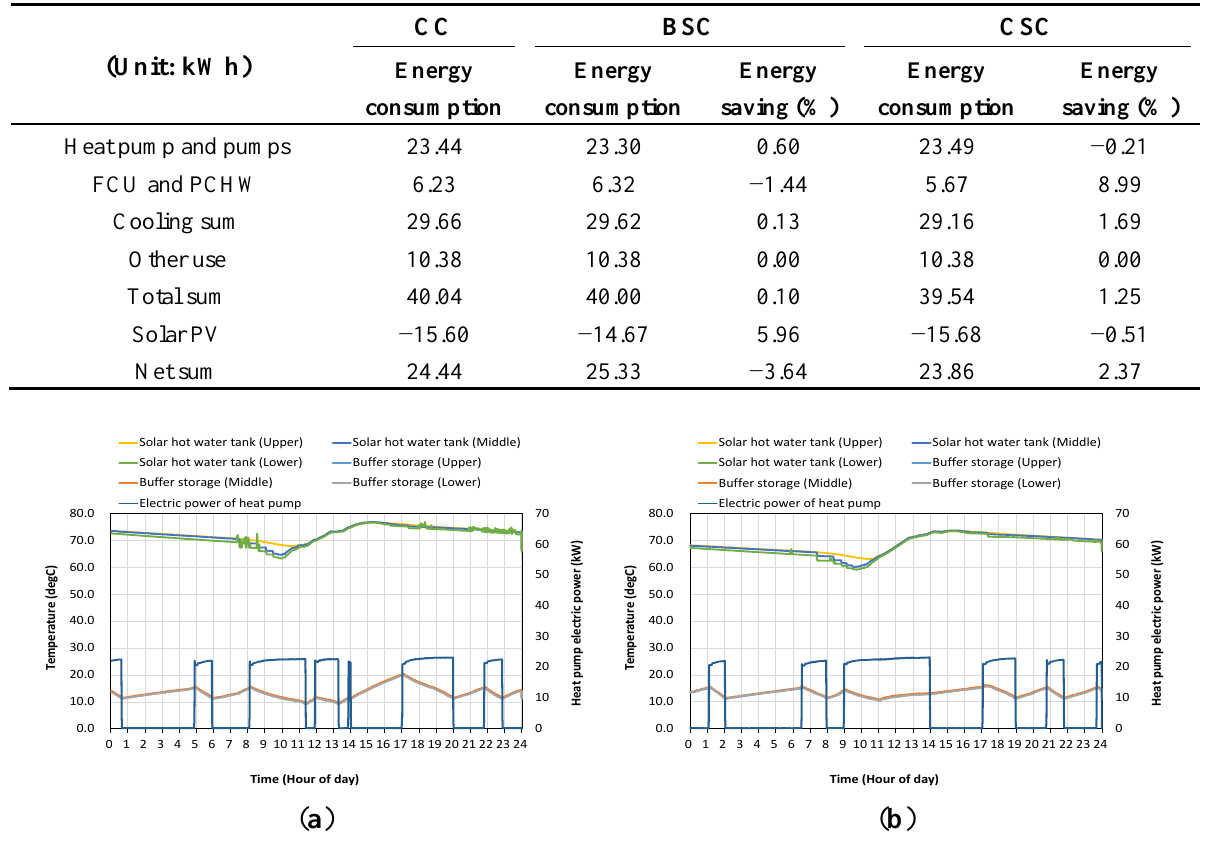
Figure 10. Temperature variation in solar hot water tank and buffer storage tank, and heat pump electric power for cooling operation mode test using ( a ) BSC and ( b )